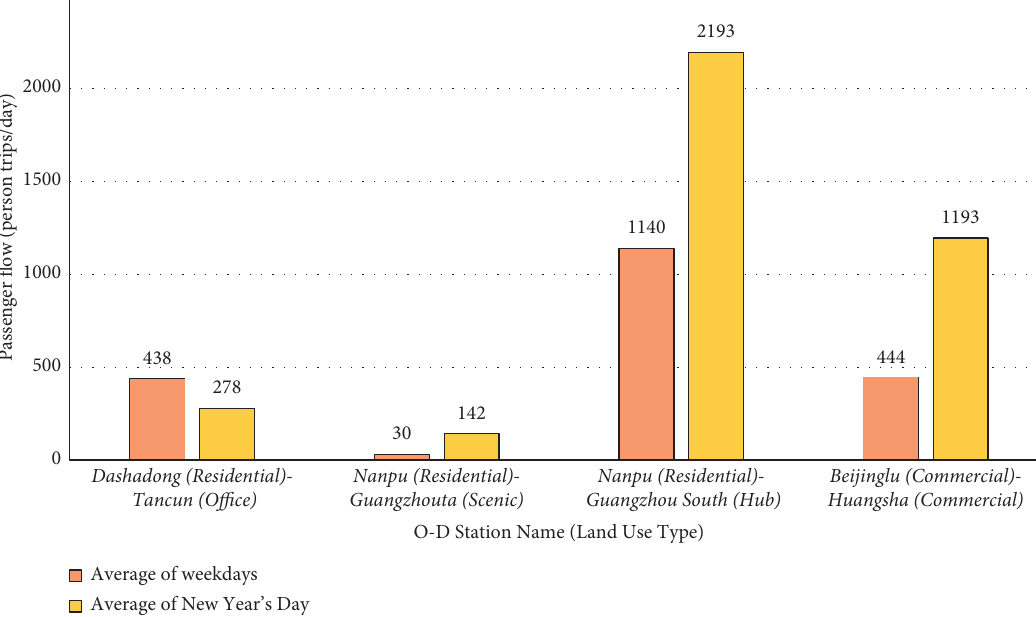
Figure 2: Comparison of O-D passenger flow during weekdays and New Year’s Day in 2016.